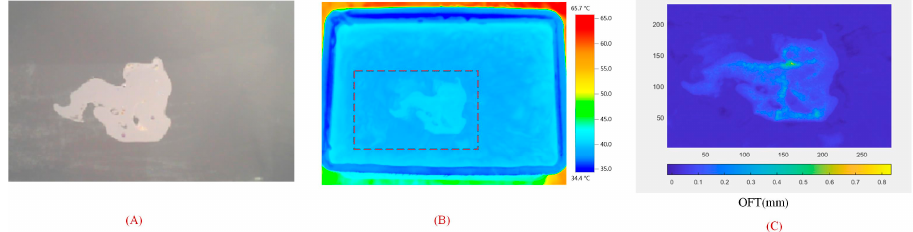
Figure 16. ( A ) RGB image of oil spill scene at 15:27 on 3 August 2022; ( B ) thermal infrared image of oil spill scene at 15:27 on 3 August 2022; ( C ) OFT distribution map at 15:27 on 3 August